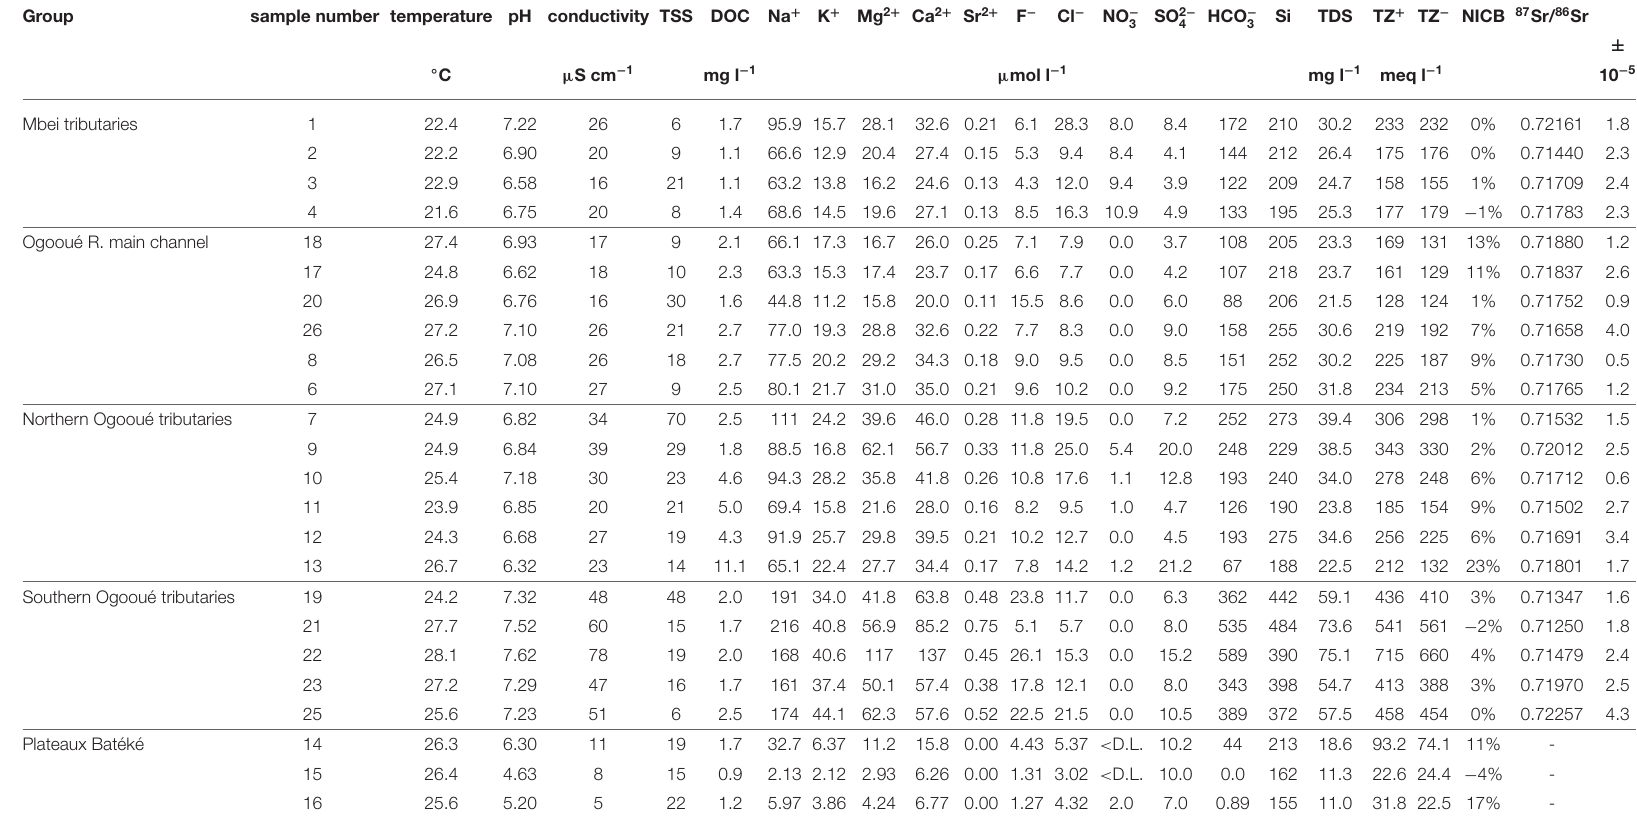
TABLE 2 | Physico-chemical parameters, major elements concentrations, DOC concentrations, and strontium isotopic ratios ( 87 Sr/ 86 Sr) measured in the river dissolved phase (i.e., < 0.22 µ m) of the Ogooué and Mbei and basins.